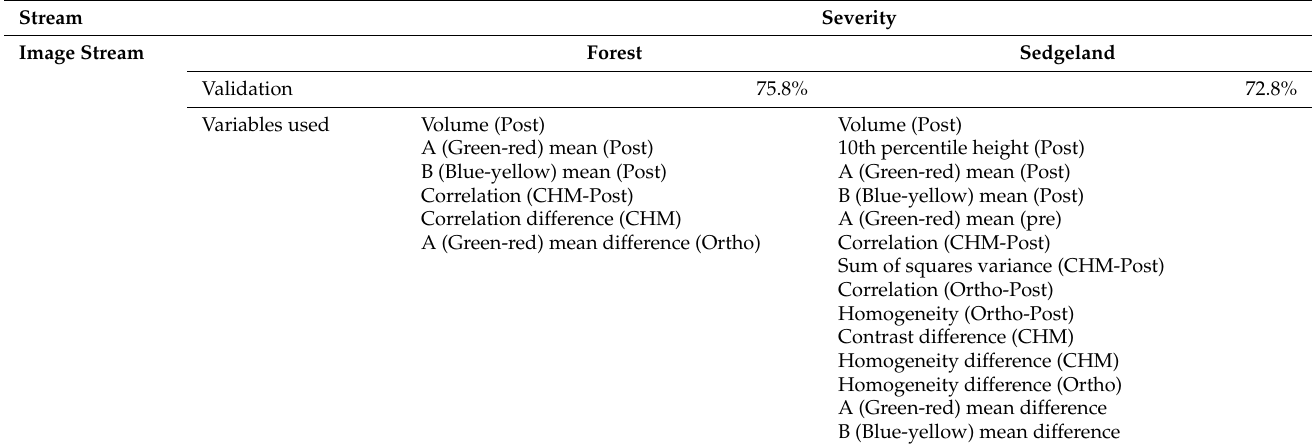
Table A2. Summary of accuracy derived from the validation dataset and predictor variables used in Image-only stream. Stream